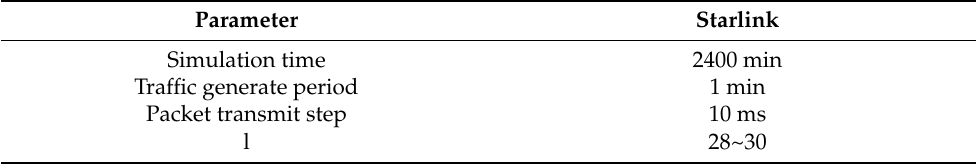
Table 2. Simulation network